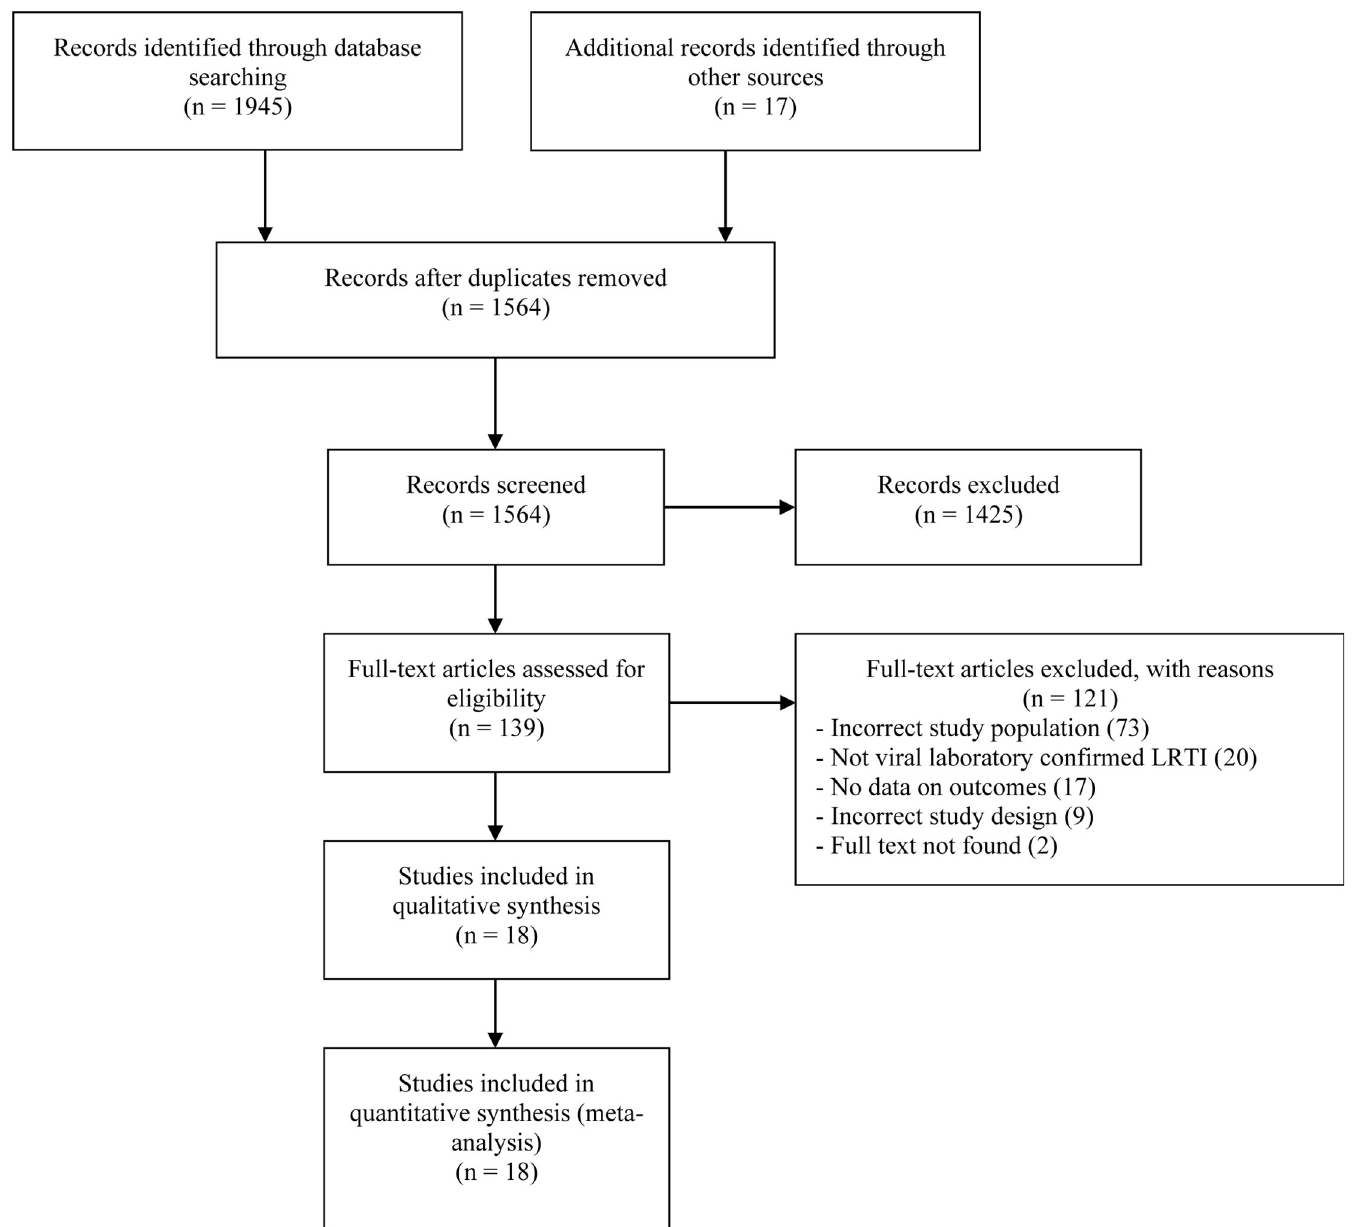
Fig 1. Flow chart for the systematic literature